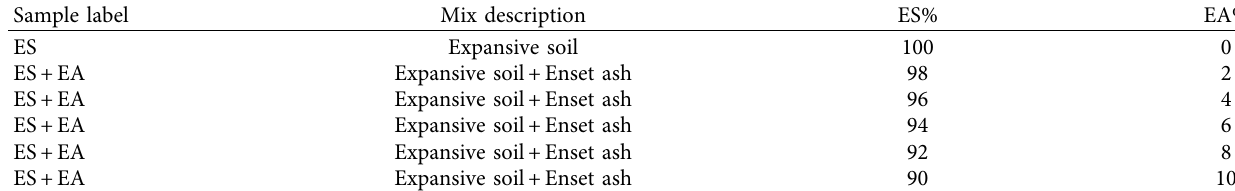
Table 4: Mix designation of raw soil with stabilizers.